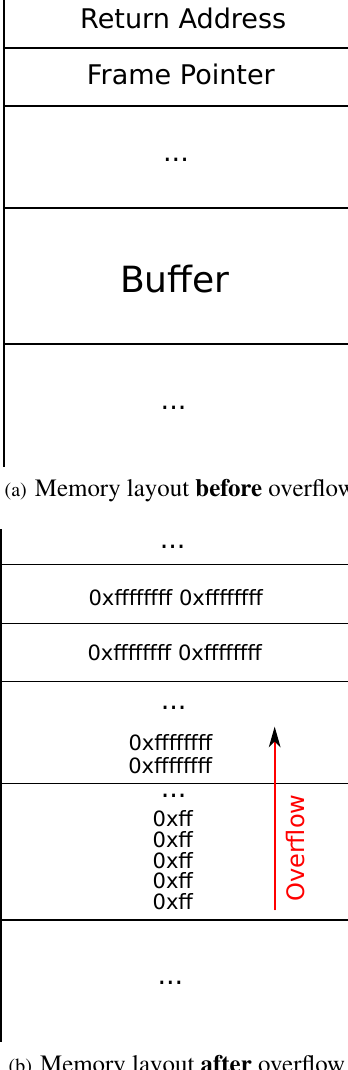
that has been made, after the buffer overflow occurred. The presented exploit does not perform any actions to bypass the stored canary, but just overwrites it completely with a value, different from the original. As reaction, the StackGuard mechanism detects the buffer overflow before returning from the overflow_function (ref. listing 11), because a check is made to verify the integrity of the canary value. Finally this leads to a signification to the user, about the buffer overflow that took place, and to the abortion of the program in the end. Undoubtedly, the StackGuard mechanism has the ability to prevent a successful exploitation by a stack smashing technique of the presented